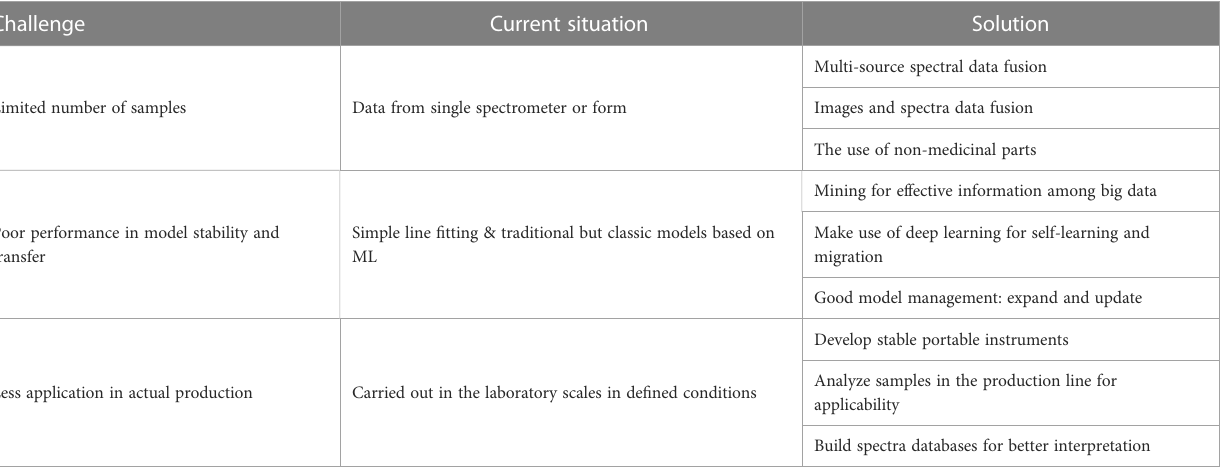
TABLE 5 Brief summary of challenges and future remarks of